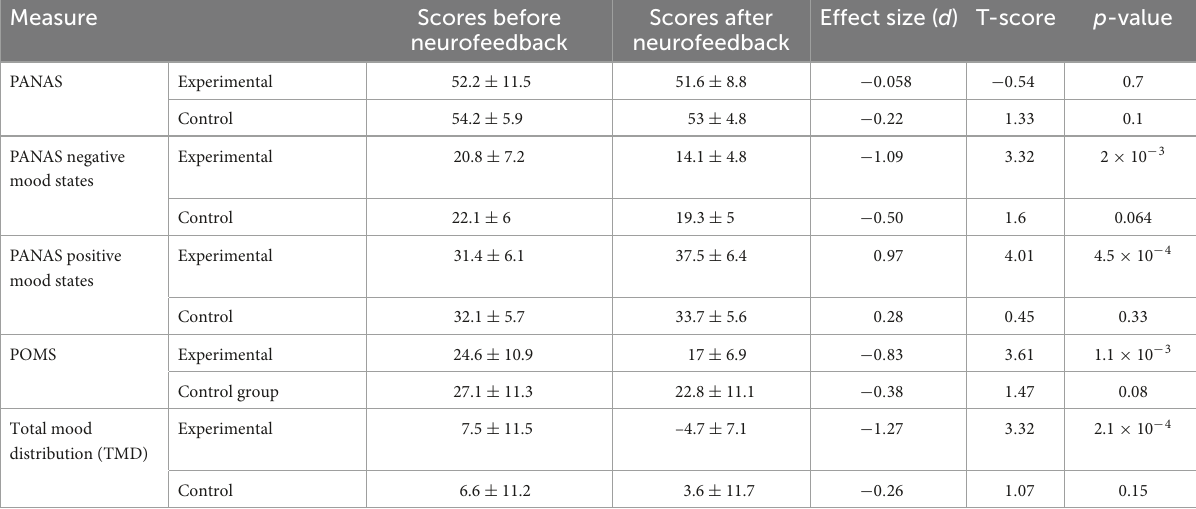
TABLE 2 Psychometric test results before and after neurofeedback for the experimental and control groups. Measure Scores before